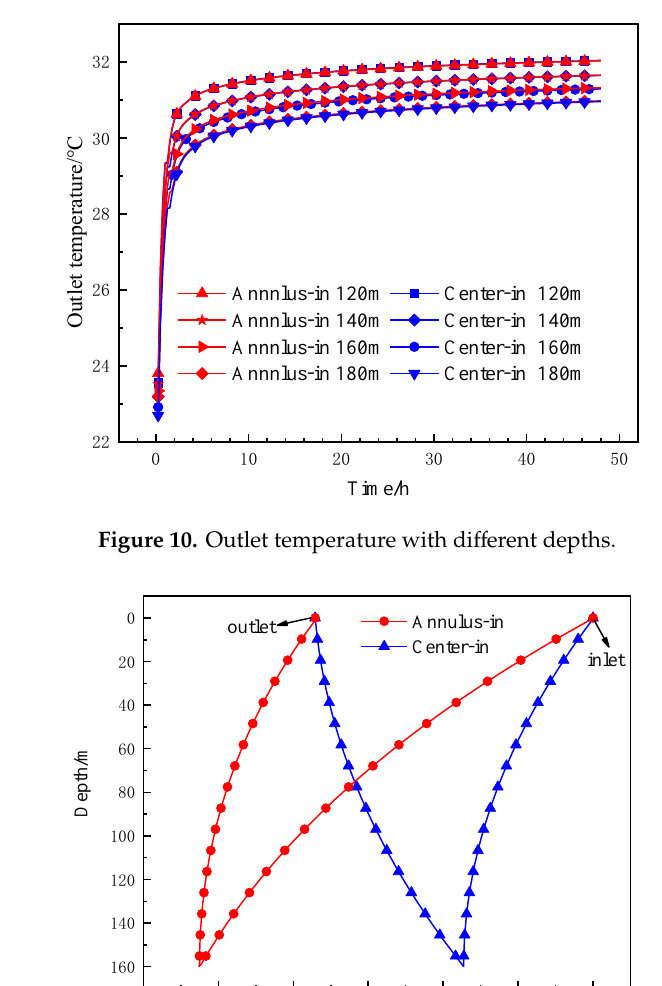
Figure 10. Outlet temperature with different depths.